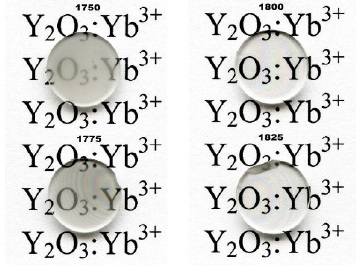
Fig. 8 (Y 0.93 Yb 0.05 La 0.005 Zr 0.015 ) 2 O 3 optical ceramics obtained by vacuum sintering for 10 h at different temperatures and annealed in air at 1400 ℃ for 15 h.